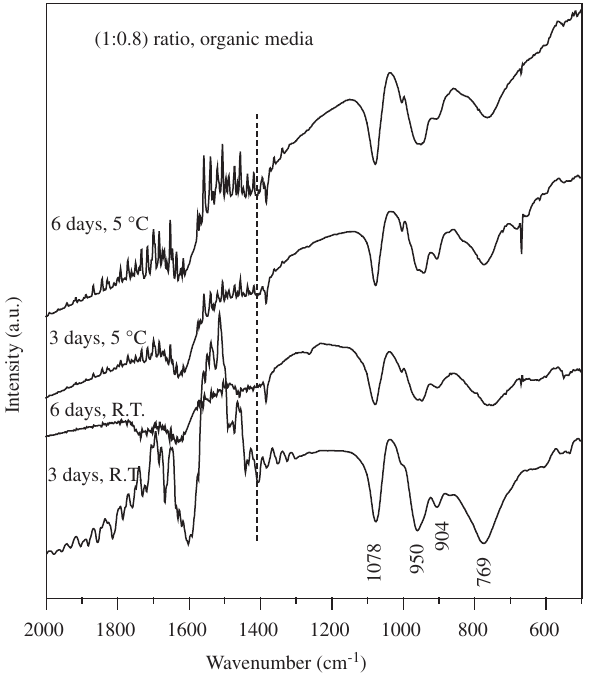
Figure 4. Infrared spectra of the materials obtained through the ion exchange of the (NH ) P Mo O .12H O salt in contact with (1:0.8) salt:resin weight 4 6 2 18 62 2 ratio and variable time and temperature of exchange in ethanol media. The dash line indicates the position of the ammonium